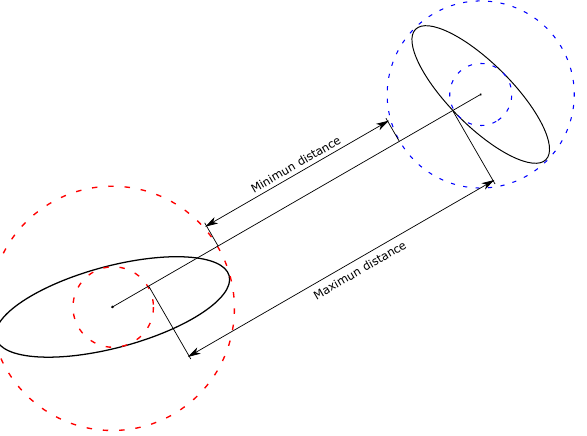
Figure 3. Minimum and maximum distance between